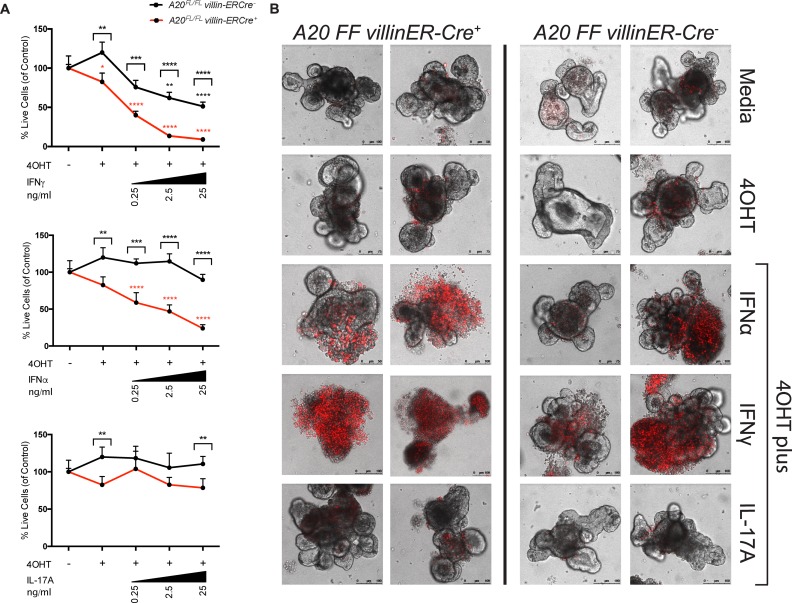
A20 deletion enhances the cytotoxic effects of IFNα and IFNγ.(A) Quantification of cell viability by CellTiter Glo 3D assay in organoid cultures after stimulation with three doses of rIFNγ, rIFNα, or rIL-17A for 24 hours. Significance of Cre+ or Cre- was assessed separately by ANOVA. Stars above data points represent statistical significance of cytokine treatment relative to the media control within either the Cre+ (red) or Cre- (black) line after post-hoc comparisons were made by t-test, correcting for multiple comparisons by Scheffe method. Stars above brackets indicate a significant difference between A20-sufficient (Cre-, black) and A20-deficient (Cre+, red) culture within the indicated media condition by t-test. *P<0.05, **P≤0.01, ***P≤0.001, ****P≤0.0001. (B) Representative confocal images of propidium iodide (PI)-stained organoids treated for 24 hours with 4OHT followed by 10 ng/ml of indicated cytokine for 24 hours. Two organoids representing the range of PI staining are shown for each condition.